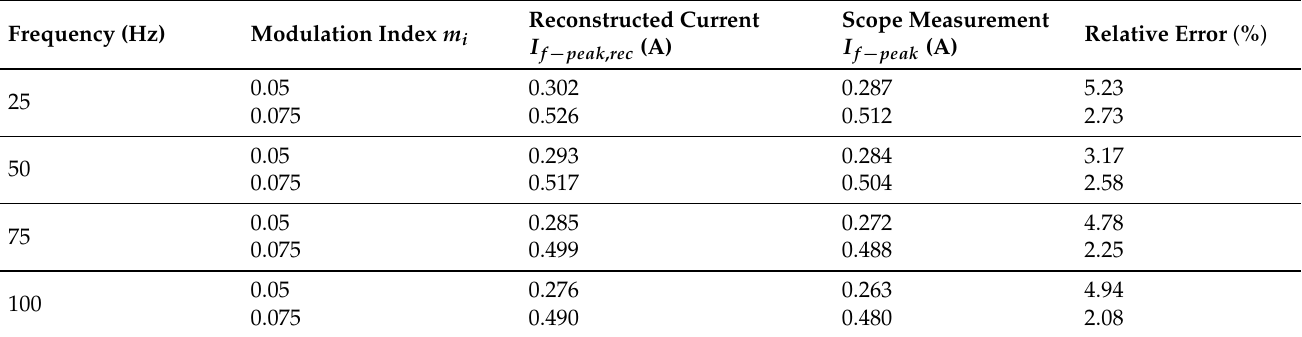
Figure 12. Single-shunt reconstruction of a three-phase current using SVM for a low modulation index under the transient condition: ( a ) modulation index step from m i = 0.075 to m i = 0.15 at f = 100 Hz; ( b ) DC-link voltage leap from U DC = 24 V to U DC = 48 V at f = 10 Hz and m i = 0.075. Table 3. Performance index for the measurement